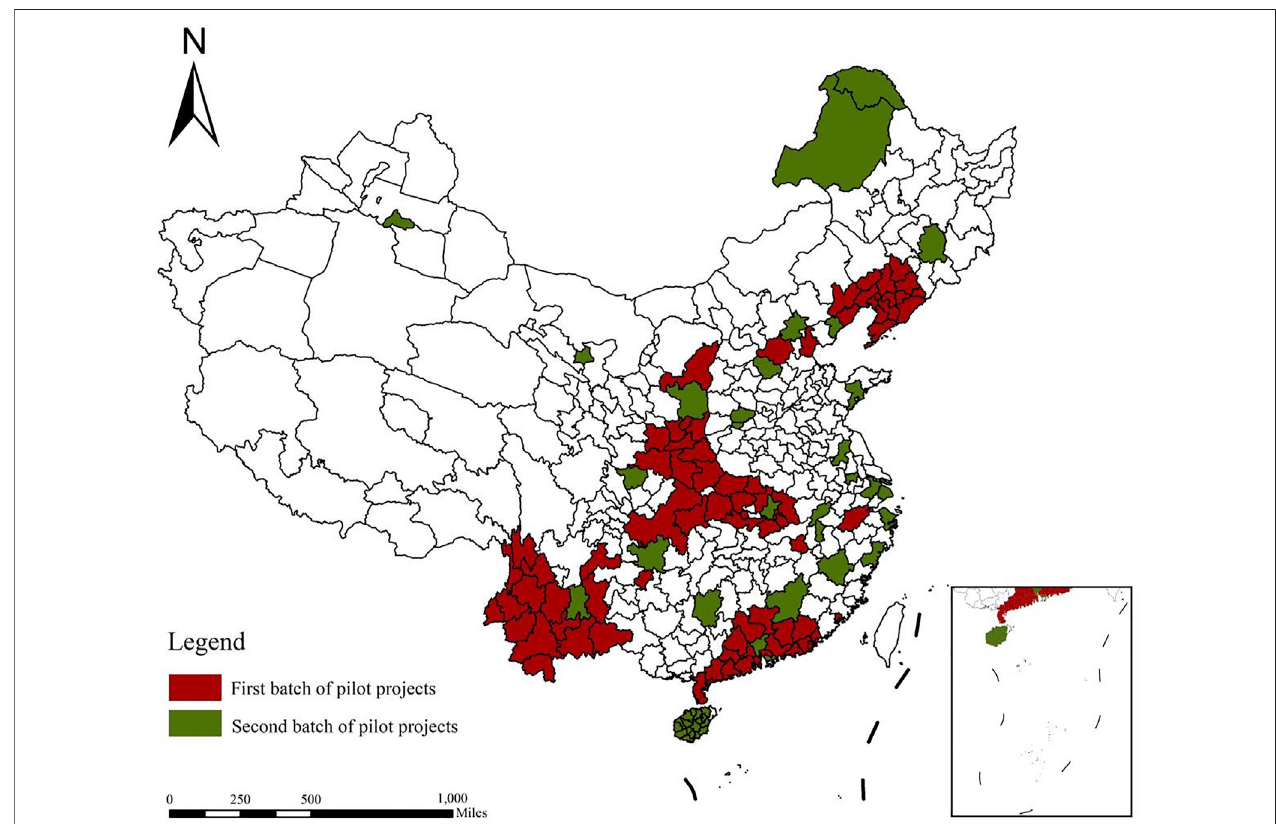
FIGURE 1 | Geographical distribution of China ’ s low-carbon